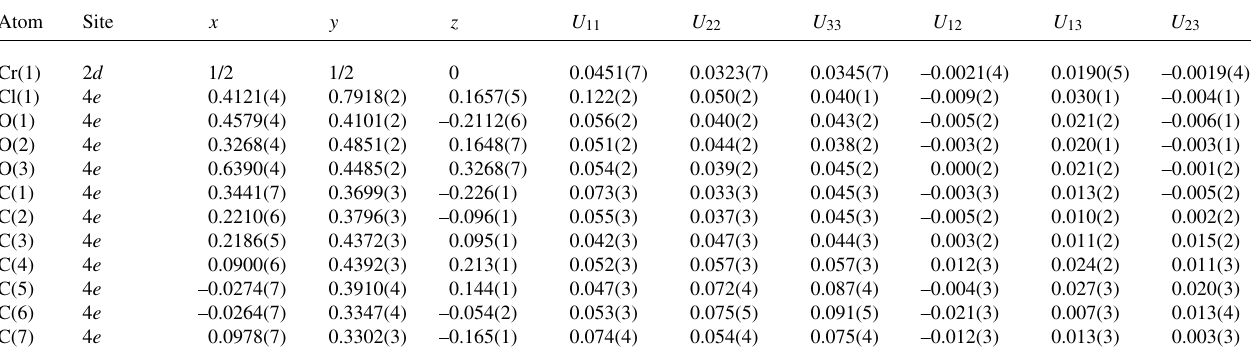
Table 3. Atomic coordinates and displacement parameters (in Å 2 )